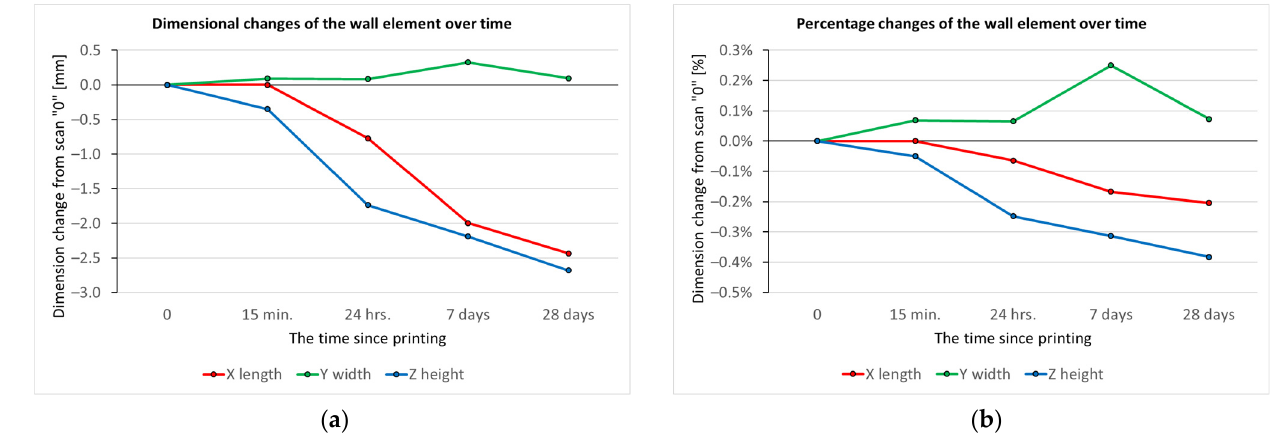
Figure 12. Dimensional changes of a wall element over time (based on measurements of plane distances): ( a ) absolute; ( b ) percentage.